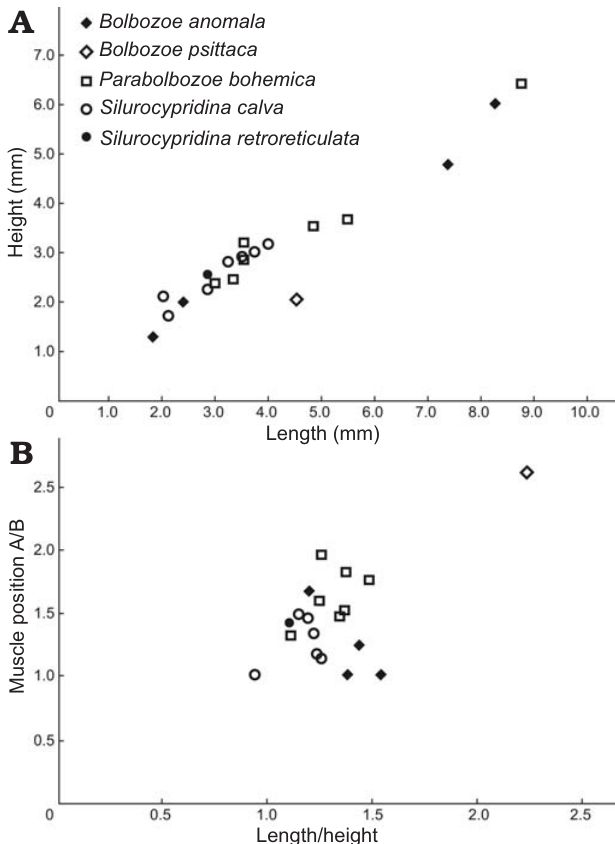
Fig. 3. Valve length/height plot ( A ) and position of the adductor muscle scar (A/B, where A and B are the distances between the muscle scar and the posterior end of the valve and the ventral margin, respectively) against length/height ( B ) of complete specimens of bolbozoid and cypridinid spe- cies from the Holy Cross Mountains, Poland; Ludlow Series,